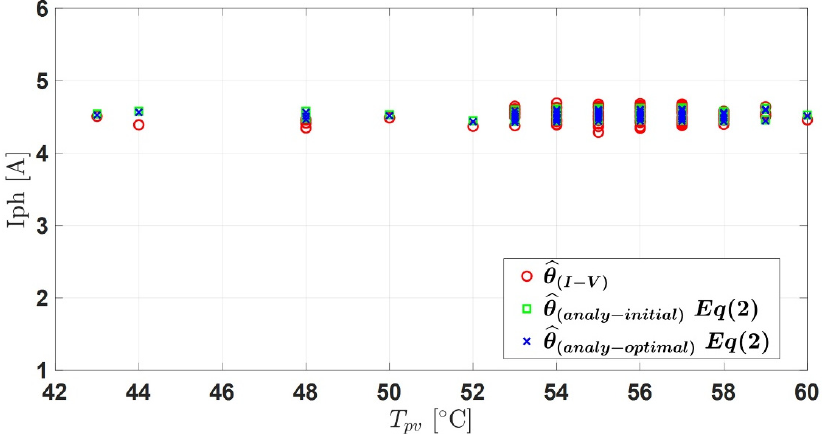
Figure 13. Evolution of the photocurrent ( I ph ) with T pv for 750 W/m 2 ≤ G poa ≤ 780 W/m 2 . Analytical Model of the Diode Saturation Current ( I 0 ) As can be noticed in Equation (3), I 0 only depended on the temperature and the reference values V oc _ ref , k v _ ref , I sc _ ref , and k i _ ref . The last two were determined in the previous section. Figure 14 and Table 6 show the results. I 0 slightly increased with T pv . The MAPE I 0 , was equal to 7.34%.